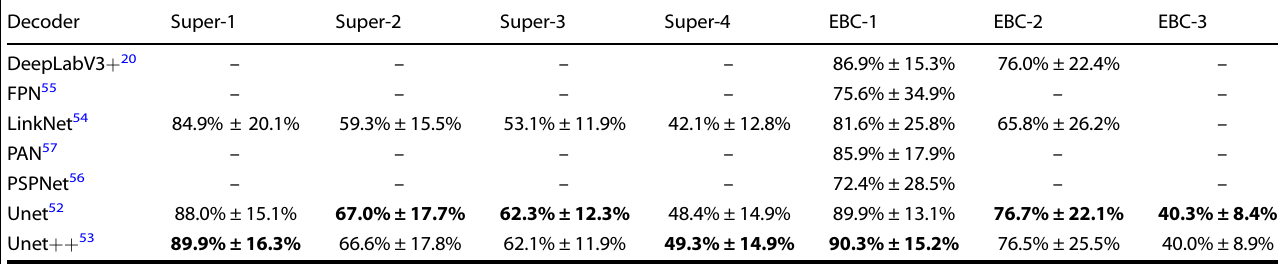
Table 3. Average performance of decoder architectures for each experiment.